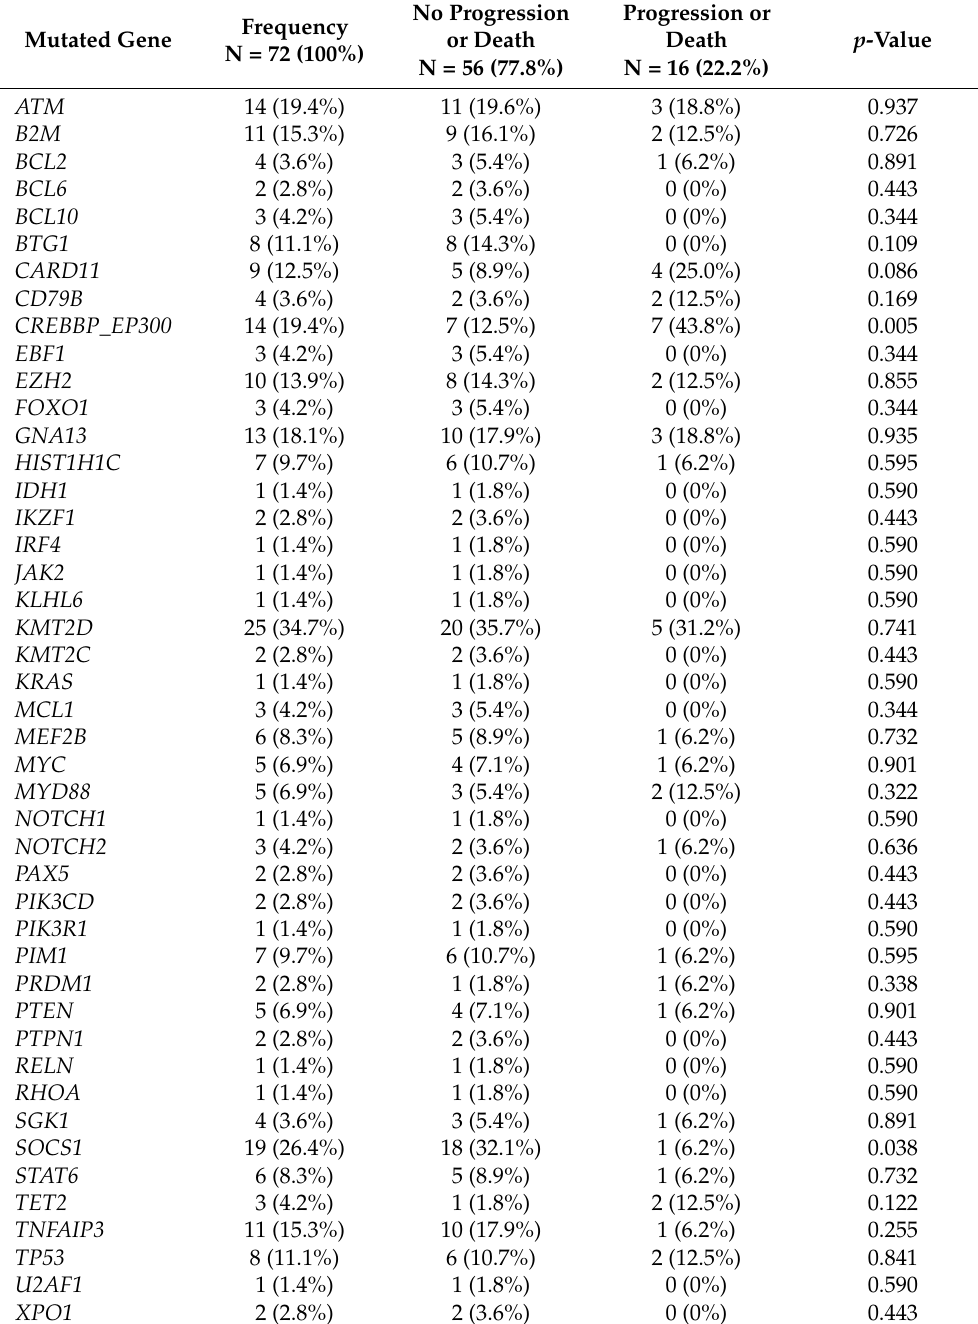
Table 2. Impact on progression-free survival of the mutations found in 46 of the assessed genes, in which mutations were